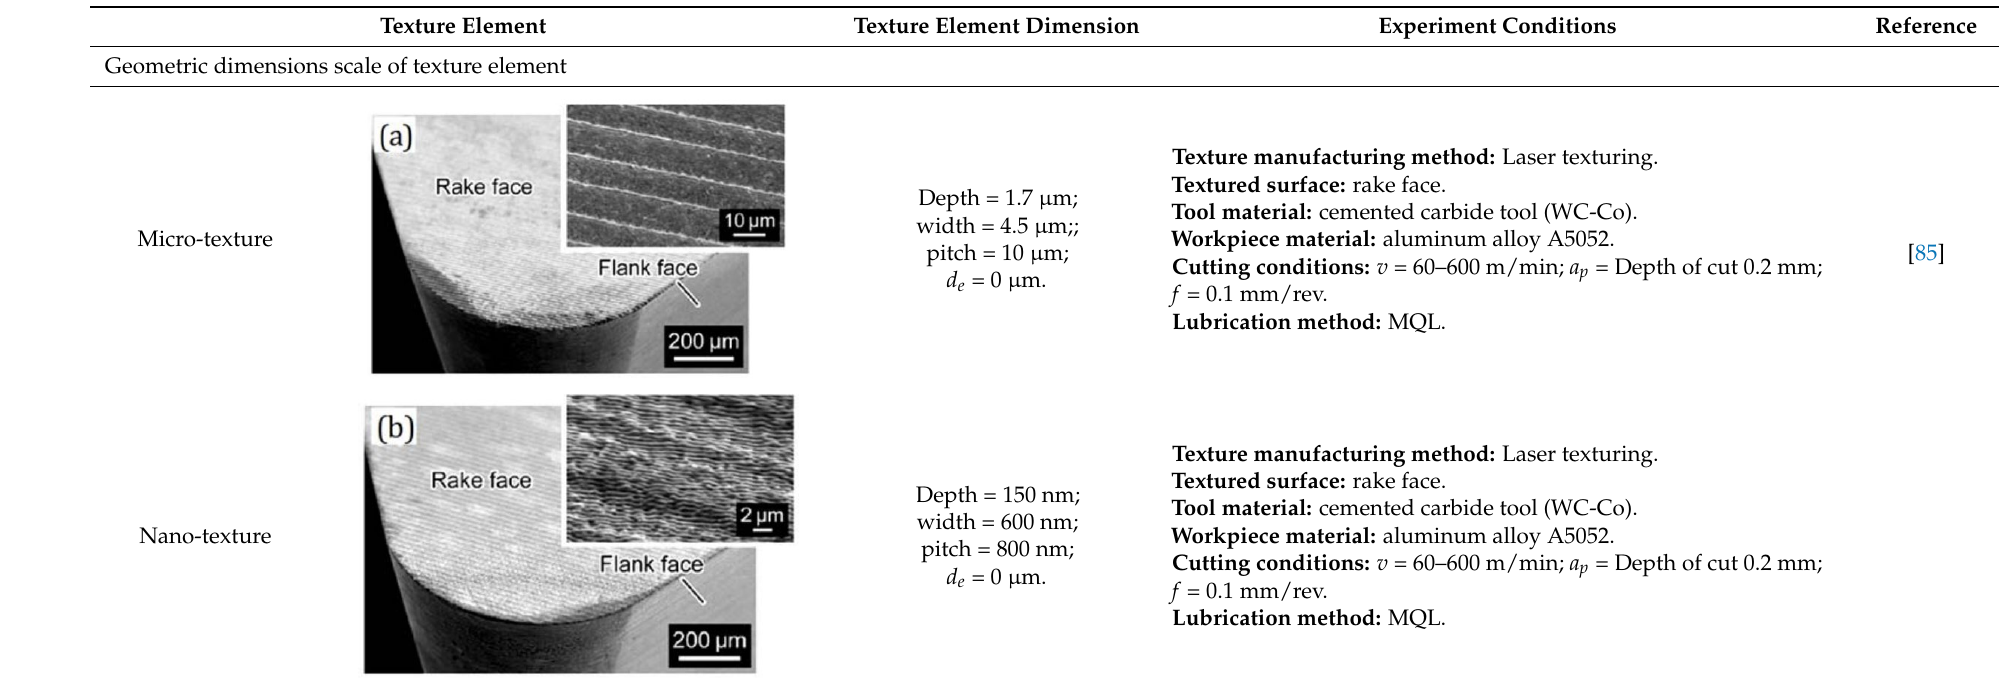
Table A3. Classification of several designed textured cutting tools according to the previously proposed categorization.